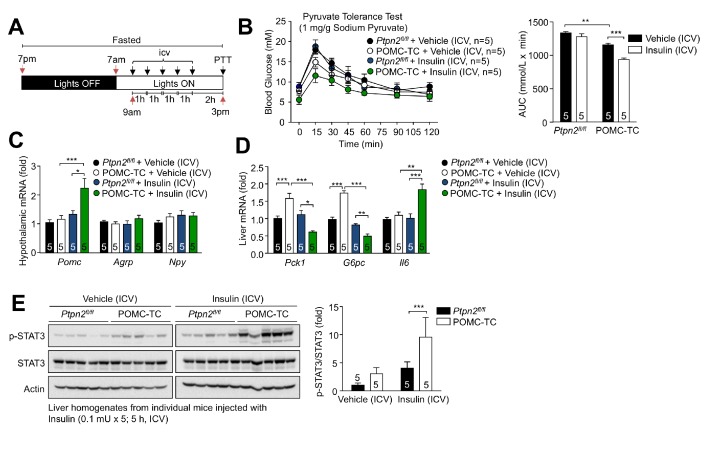
Deletion of TCPTP in POMC neurons enhances the insulin-induced and POMC-mediated repression of hepatic gluconeogenesis.(a) Experimental paradigm schematic. 8–10 week-old POMC-TC or Ptpn2fl/fl overnight fasted male mice were administered intracerebroventricularly (ICV) saline or insulin (0.1 mU/animal, 5 injections over 5 hr) as indicated and subjected 1 hr later to either (b) pyruvate tolerance tests (1 mg/g; areas under curves were determined and statistical significance assessed using a two-way ANOVA followed by Sidak multiple comparison test) or hypothalami and livers were extracted for (c-d) quantitative PCR (significance assessed using a one-way ANOVA followed by Tukey multiple comparison test) and (e) immunoblotting (significance assessed using a two-way ANOVA followed by Sidak multiple comparison test). Representative and quantified results are shown (means ± SEM) for the indicated number of mice.